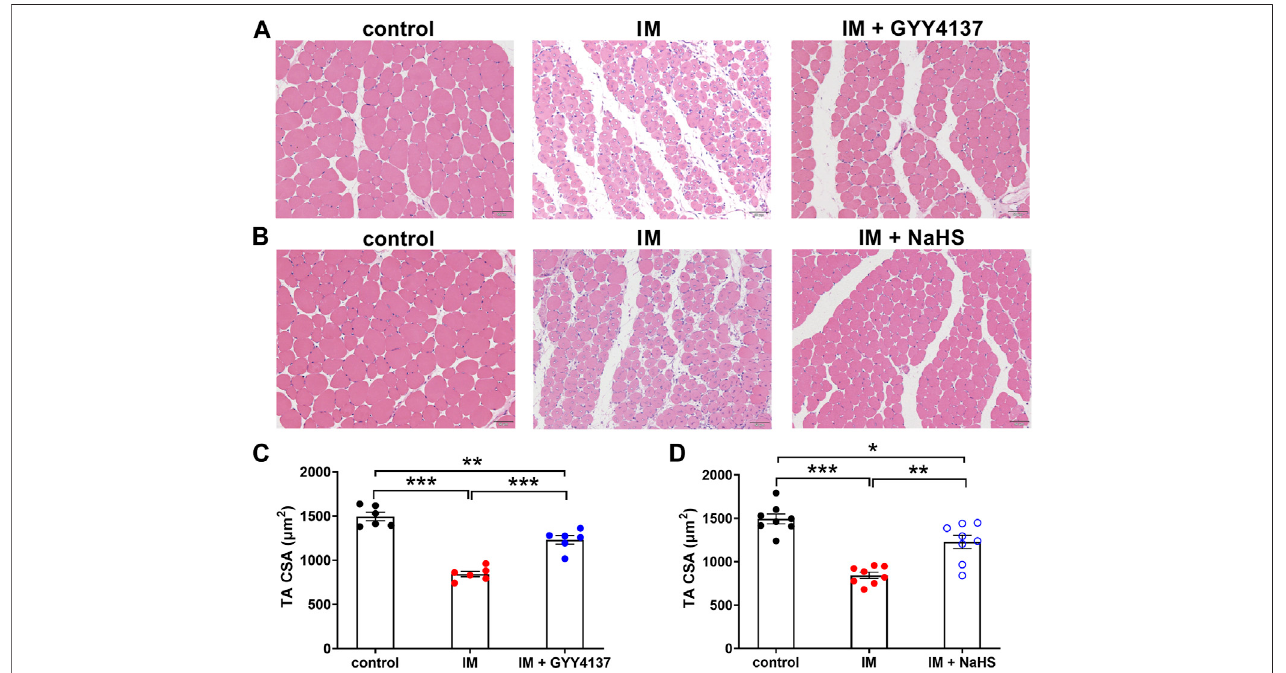
FIGURE 1 | H2S donors alleviate the immobilization (IM)-induced muscle atrophy. Mice were subjected to IM and treated with GYY4137 (A) , 50 μ g/kg/d, ip), or NaHS (B) ,1.12 mg/kg,twiceaday,ip)for2 weeks.ThecontrolandIMgroupsreceivedidenticaldosesofsalinefor2weeks.A&b,Representativephotomicrographsof H&E-stained TA muscles (scale bars, 50 μ m). (C) , Quanti fi cation of fi ber CSAs of TA muscle in control, IM, and IM + GYY4137 mice (n = 6 in each group). (D) , Quanti fi cationof fi berCSAsofTAmuscleincontrol,IM,andIM+NaHSmice(n=8ineachgroup).Datarepresentmeans±SEM.* p < 0.05,** p < 0.01,*** p < 0.001.